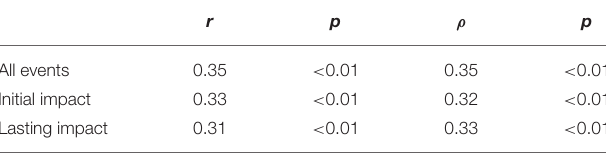
TABLE 7 | Cohen’s Kappa Coefficient ( κ ) for the agreement between the children and the parents on the individual items ( N =